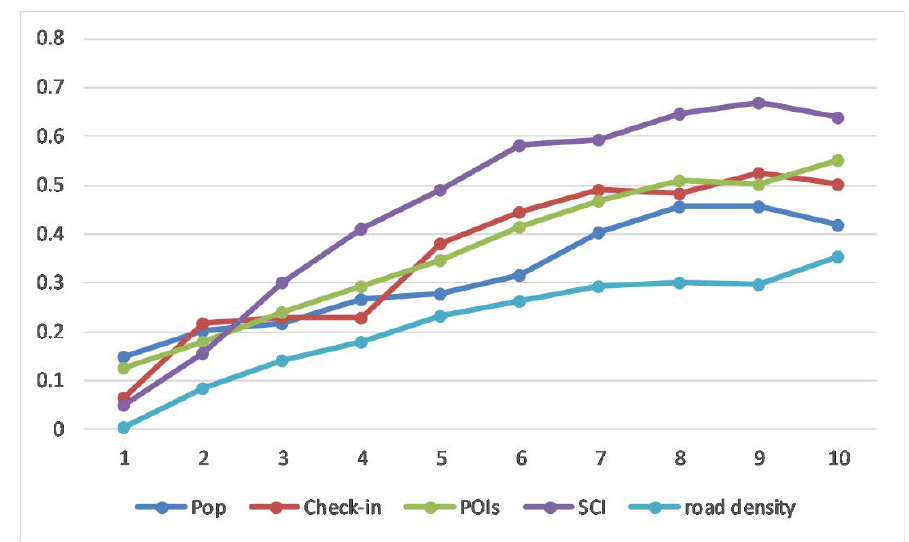
Figure 8. PCC of features and sales within different grid sizes.